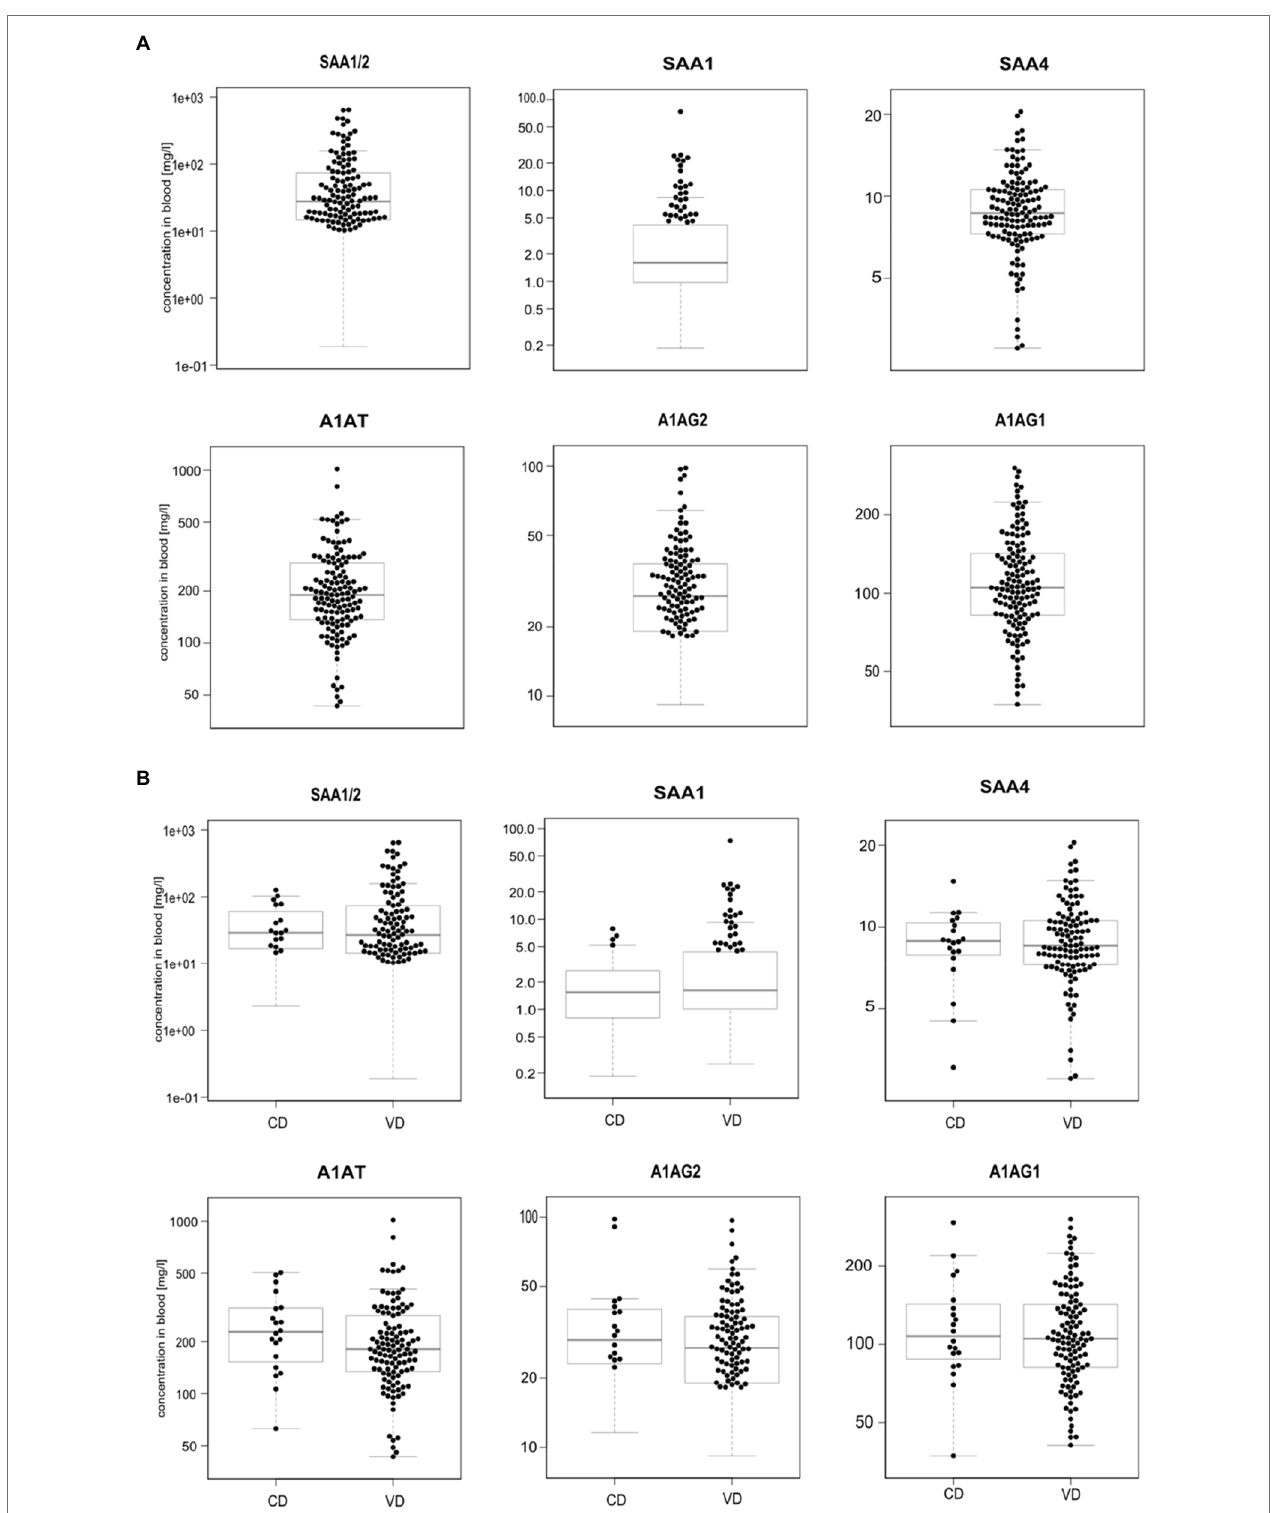
FIGURE 3 | Boxplots of acute-phase protein levels were determined in 134 neonatal DBS (A) and grouped according to the delivery mode (VD, vaginal delivery, CD, cesarean delivery; B ). Sample concentrations >LOQ marked with black dots. Y-axis is in